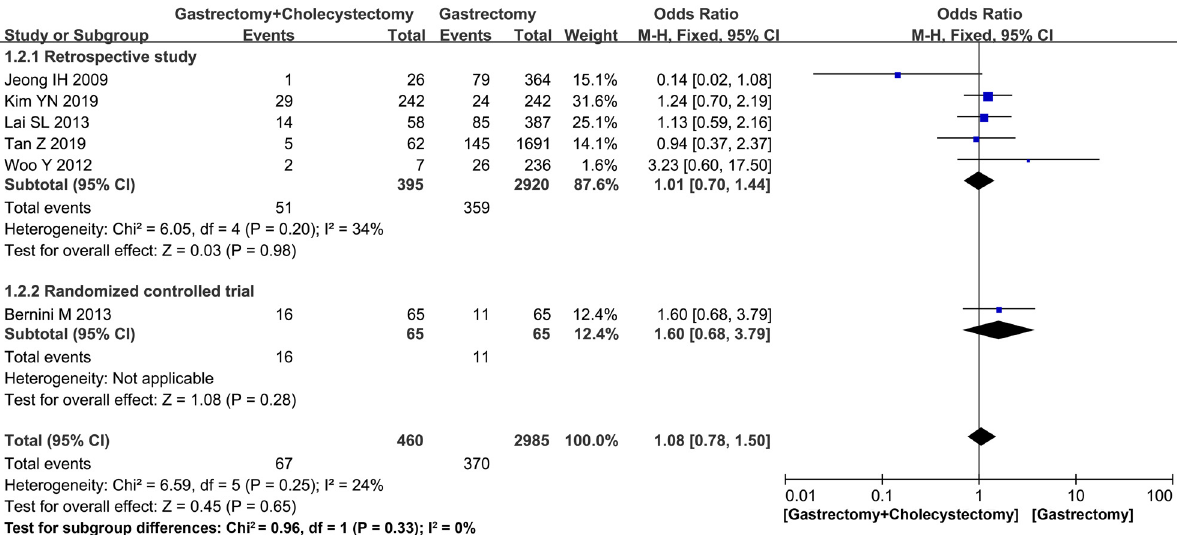
Figure 2: Forest plot showing postoperative overall complications.